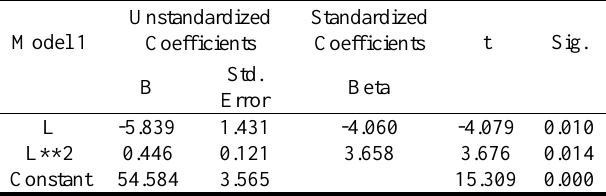
Tab.4. The regression coefficient of regression model